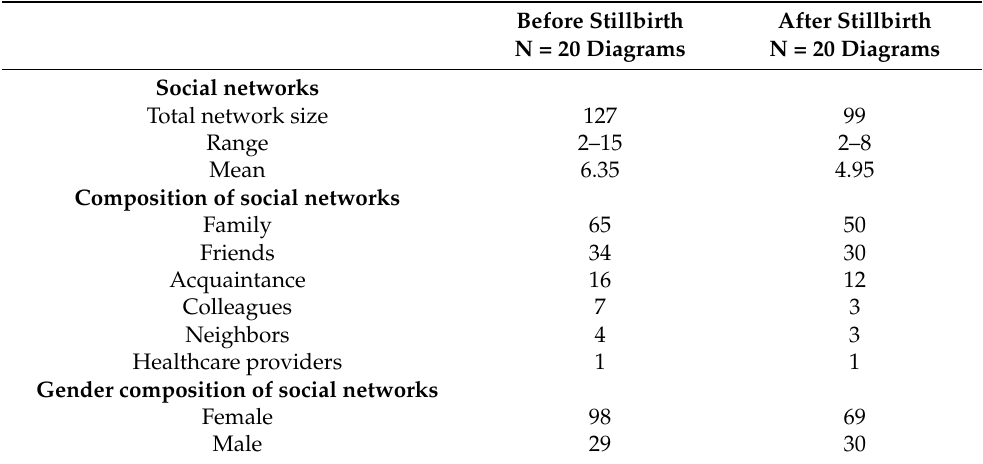
Table 3. Description of the participants’ social